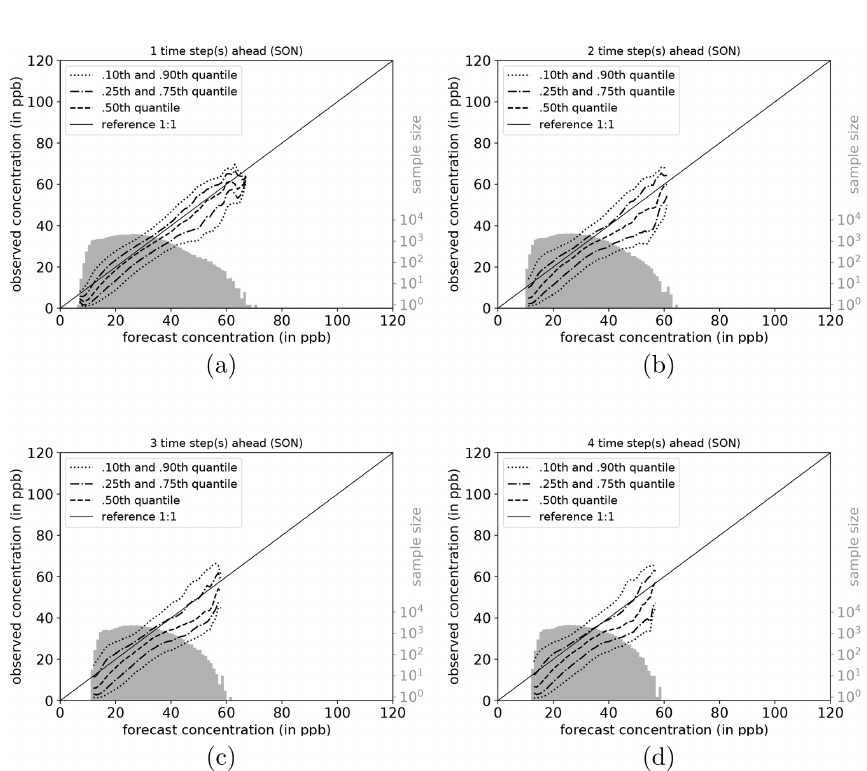
Figure A7. Same as Fig. 6 but for SON.